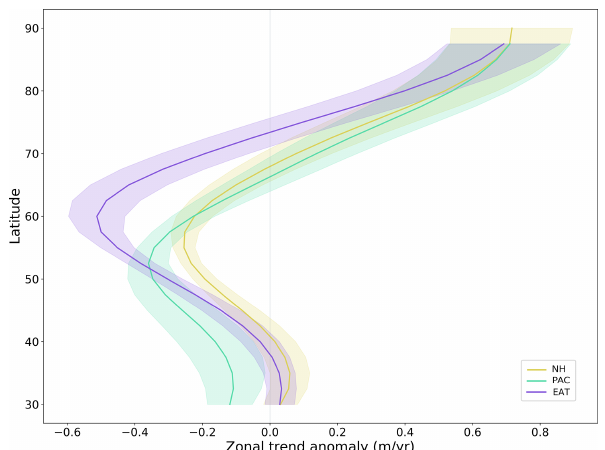
Figure 9. Multi-model average of the zonal-mean trend anomaly of the geopotential height at 500hPa for SSP5–8.5. The zonal trend anomaly is shown for the Northern Hemisphere from 30 to 90 ◦ N (NH, yellow) and for the two sectors analysed here, PAC (green) and EAT (purple), after removing the global NH